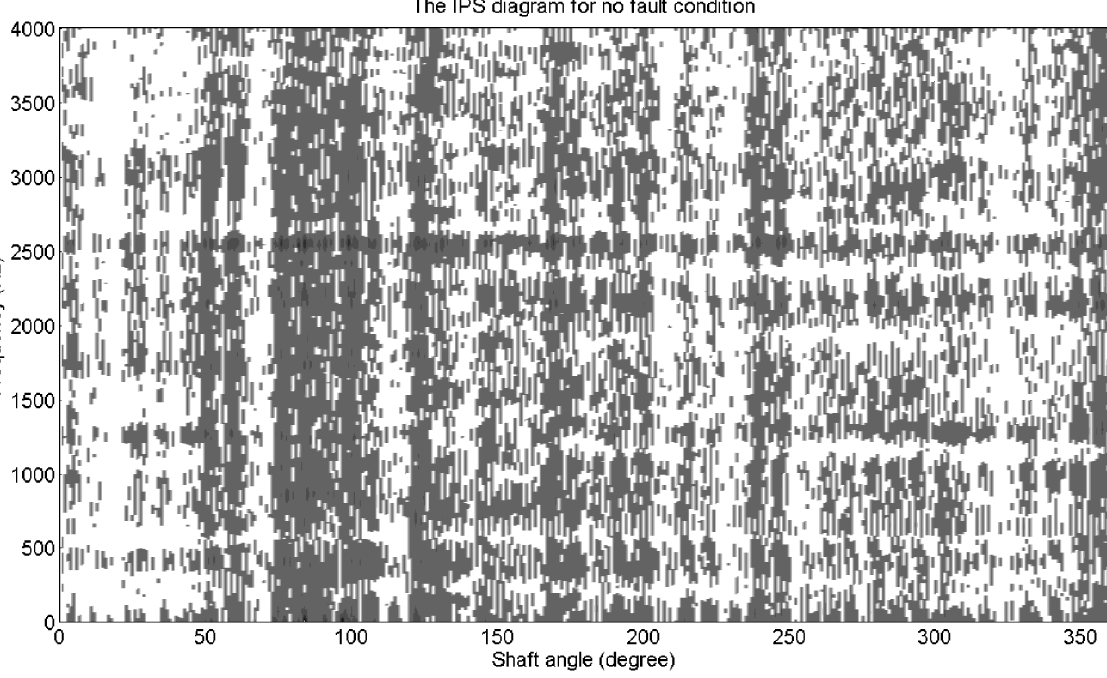
Fig. 6. IPS diagram for no-fault